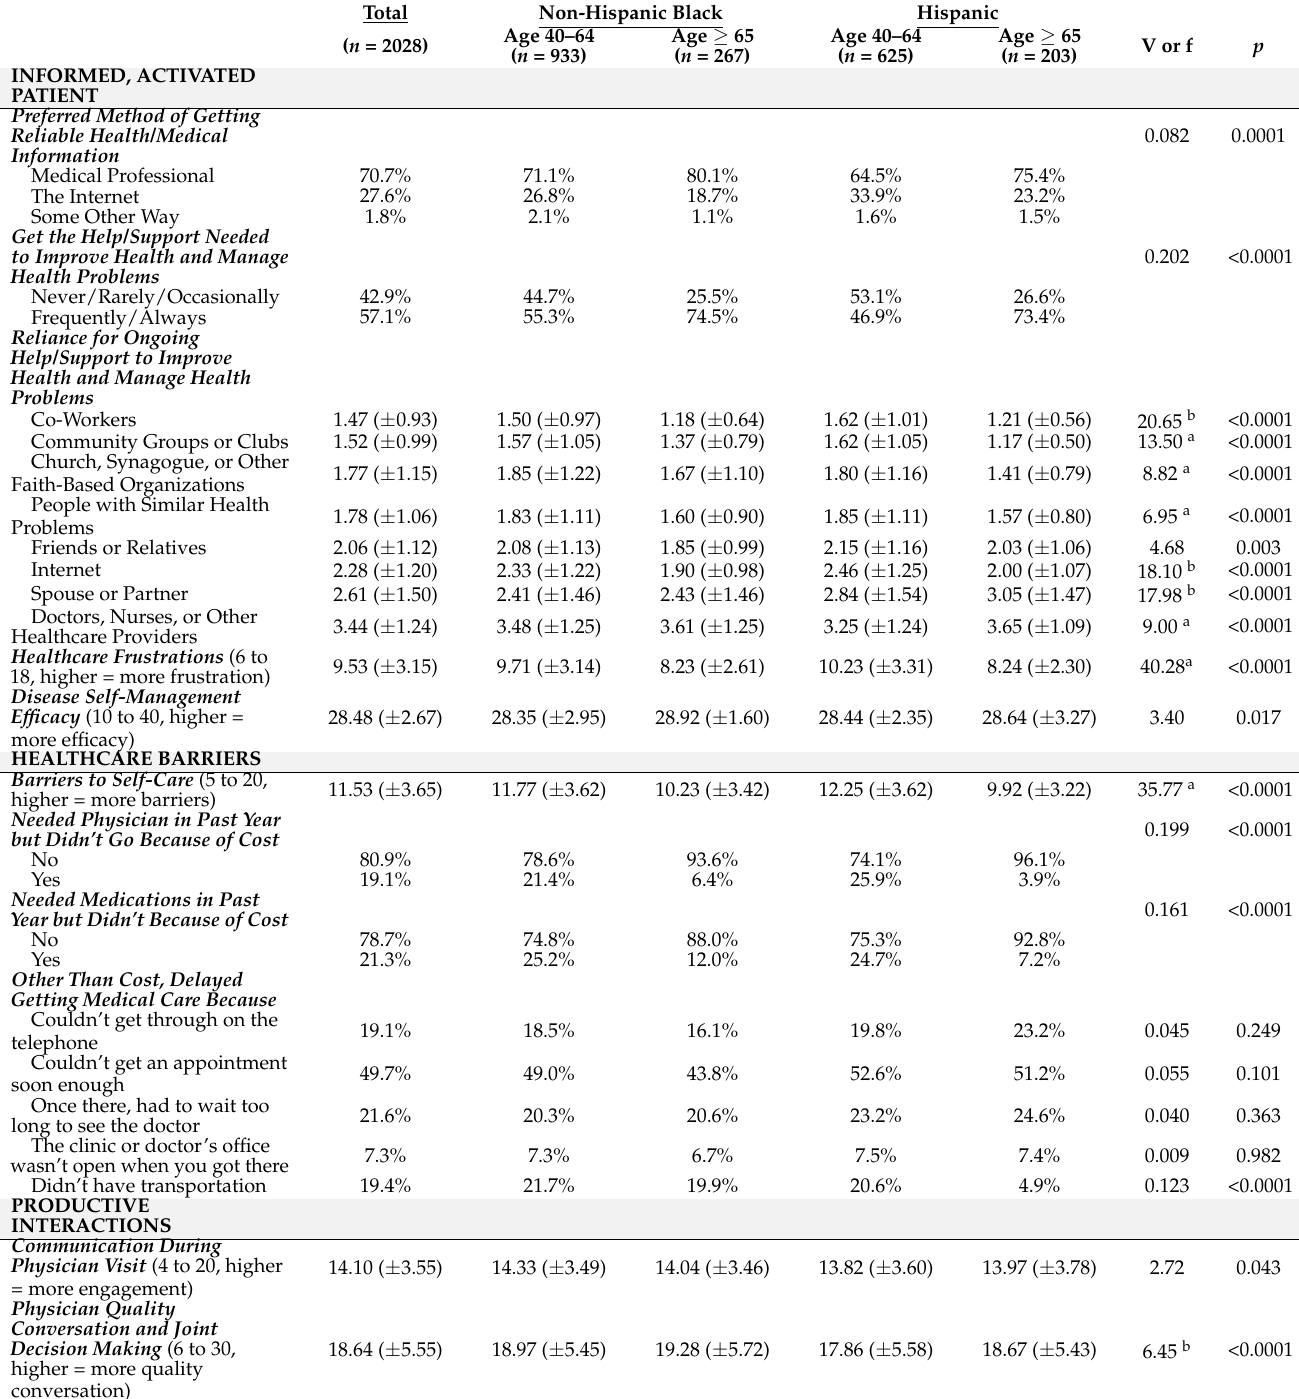
Table 4. Chronic Care Model: Patient activation, healthcare barriers, and productive interactions by race/ethnicity and age